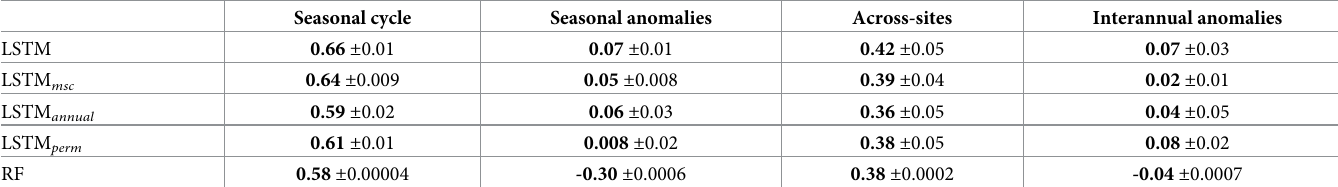
Table 4. Nash-Sutcliffe modeling efficiency of the proposed approach against the other model set-ups from the ensemble mean ± sd estimate of the 50 model runs. LSTM = LSTM model using the full depth of the Landsat time series and climate data; LSTM perm = LSTM model but the temporal patterns of both the predictive and the target variables were randomly permuted while instantaneous relationships between predictive and target variables were kept; LSTM = LSTM model but the Landsat msc time series for each band were replaced by their mean seasonal cycle, while using the actual values of air temperature (T air ), precipitation (P), global radiation (Rg), and vapor pressure deficit (VPD); LSTM = LSTM model but the Landsat time series for each band were replaced by their annual mean, while using the actual values of annual T air , P, Rg, and VPD, RF = Random Forest model using the actual values of the Landsat time series and climate